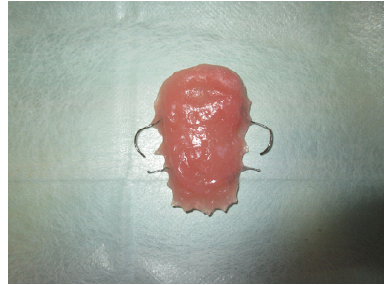
Figure 11. Extraoral vision of the palatal plate. Figure 12. Intra-oral vision after 2 months.